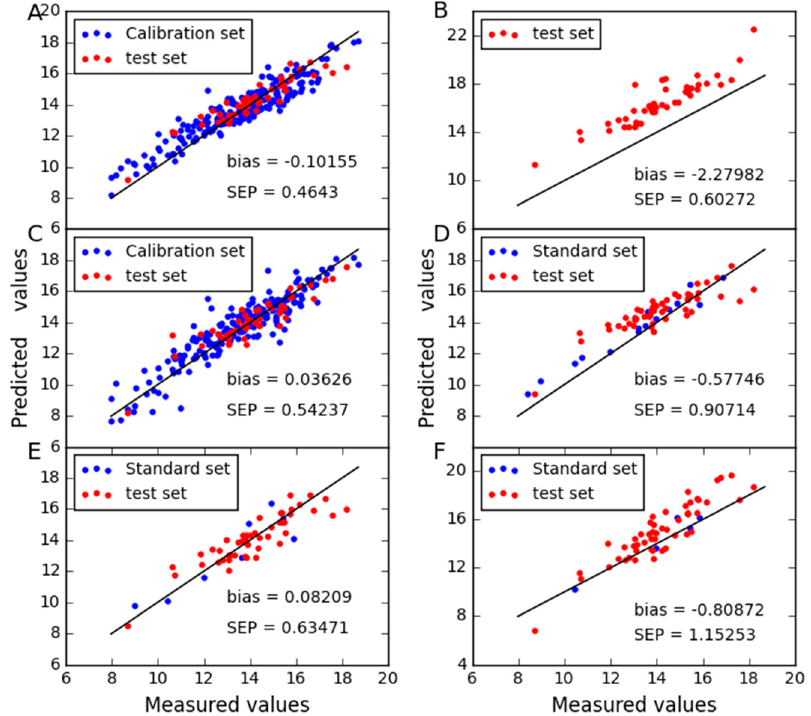
Figure 9. Protein content predicted between instruments B1 and B3 for wheat dataset as determined by ( A ) CTAI, ( B ) MSC, ( C ) TCR, ( D ) CCA, ( E ) SBC and ( F ) PDS. The blue and red dots represent the results for each sample in the train set and test set, respectively.